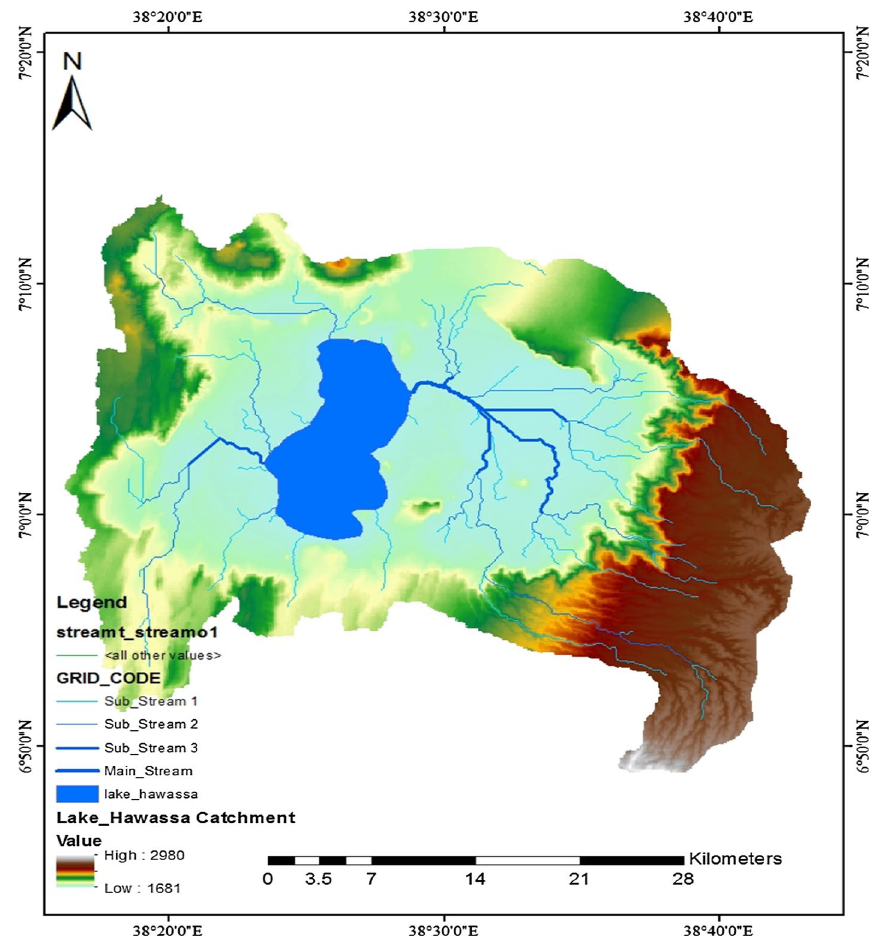
Fig. 1 Study area location